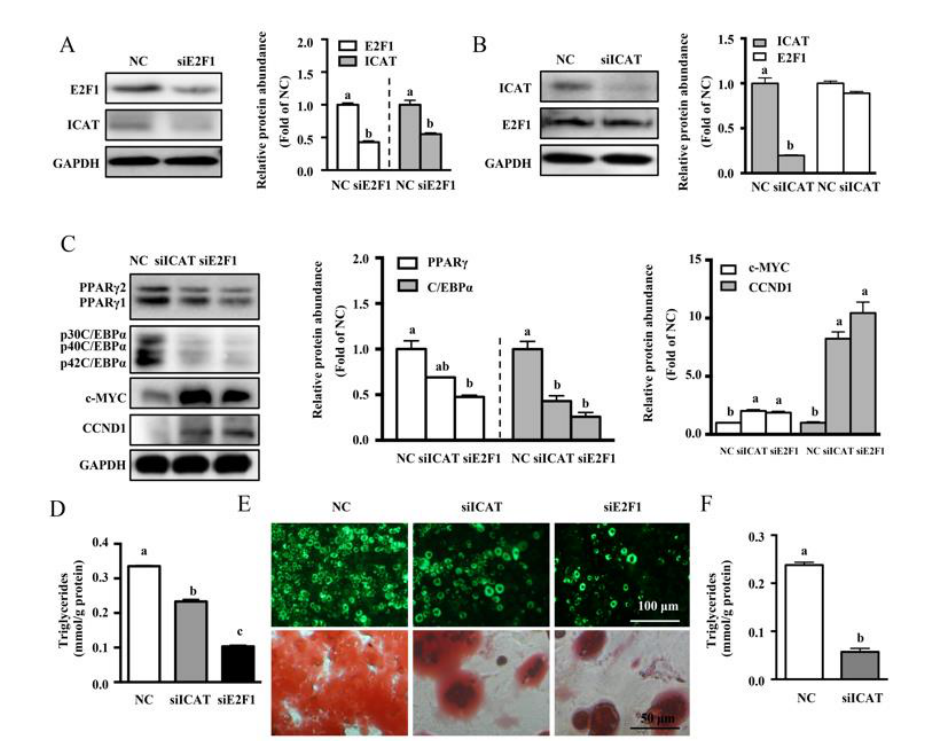
Figure5. ICATorE2F1knockdowninhibitedMDI-induceddi ff erentiationofpre-adipocytes. ( A Figure 5. ICAT or E2F1 knockdown inhibited MDI-induced differentiation of pre-adipocytes. ( A ) Protein levels for E2F1 and ICAT at 48 h after siRNA-mediated knockdown of E2F1. ( B ) Protein levels for ICAT and E2F1 at 48 h after siRNA-mediated knockdown of ICAT. ( C ) Protein abundances for adipogenic regulators and Wnt/β-catenin targets, and ( D ) TG contents of 3T3-L1 adipocytes after ICAT or E2F1 knockdown. ( E ) Representative micrographs of siE2F1 or siICAT transfected adipocytes after BODIPY493/503 (green) or oil red O (red) staining. ( F ) TG contents of stable E2F1 overexpressed 3T3-L1 adipocytes after ICAT knockdown. Values are means ± SEMs, n = 3 independent experiments. Means without a common letter differ, p < 0.05. C/EBPα, CCAAT-enhancer binding protein α; E2F1,